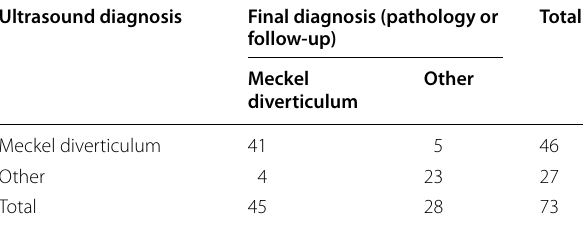
Table 3 Ultrasound diagnosis versus final diagnosis for Meckel